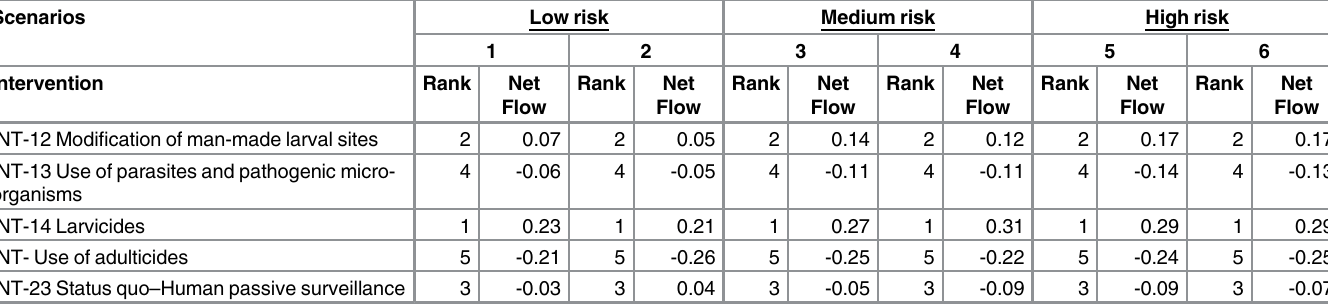
Table 7. Ranking of the currently available management interventions.